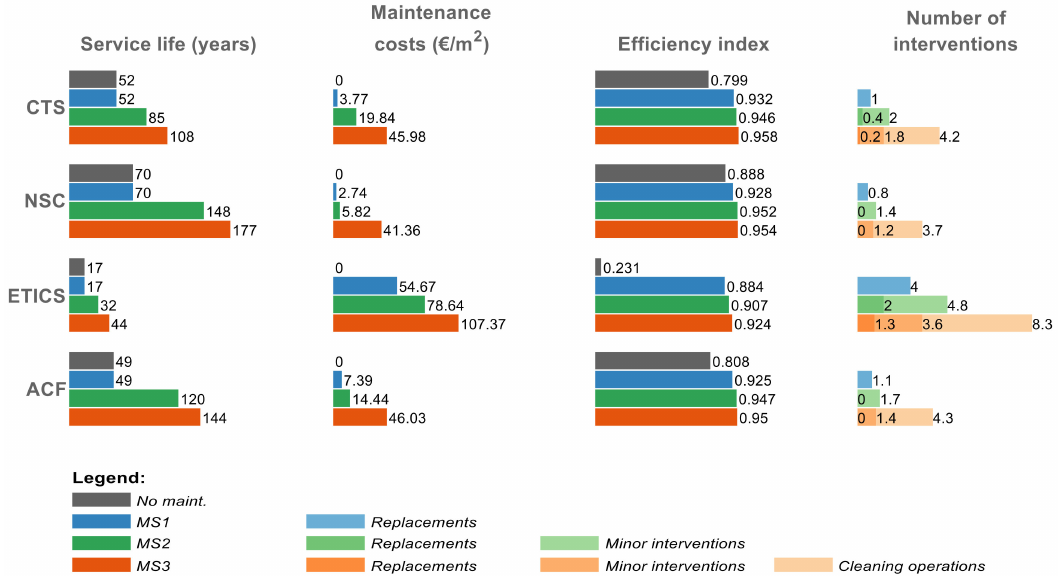
Figure 2. Comparison of the different parameters (service life, maintenance costs, efficiency index and number of interven- tions) for the situation without the impact of environmental exposure